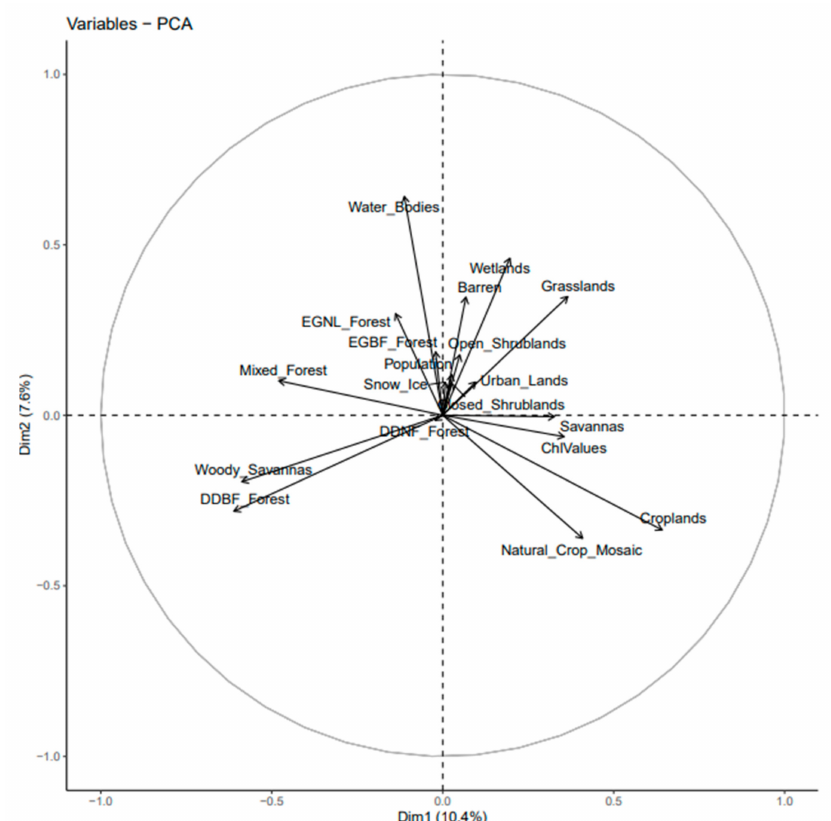
Figure 4. Principal component analysis of land cover categories, human population and Chlorophyll a concentrations for the 9313 lake dataset and their corresponding pseudo-watersheds. The principal component analysis explained 24.7% of the variation in chlorophyll a with three statistically significant axes. The most variation is explained by Principal component 1 (Dim1), explaining 10.4% of the variation, followed by Principal Component 2 (Dim2), explained 7.6% of the variation. The third principal component explaining 6.7% of the variation. The arrows depict the land cover categories and human population considered in the analysis. The length of the arrows indicated the level of influence while the angle while the angle between two arrows suggest the correlation between two variables. The acronyms are as follows: Chl = Chlorophyll, DDBF = Deciduous Broadleaf, EGBF = Evergreen Broadleaf, DDNF = Deciduous Needleleaf, EGNL = Evergreen